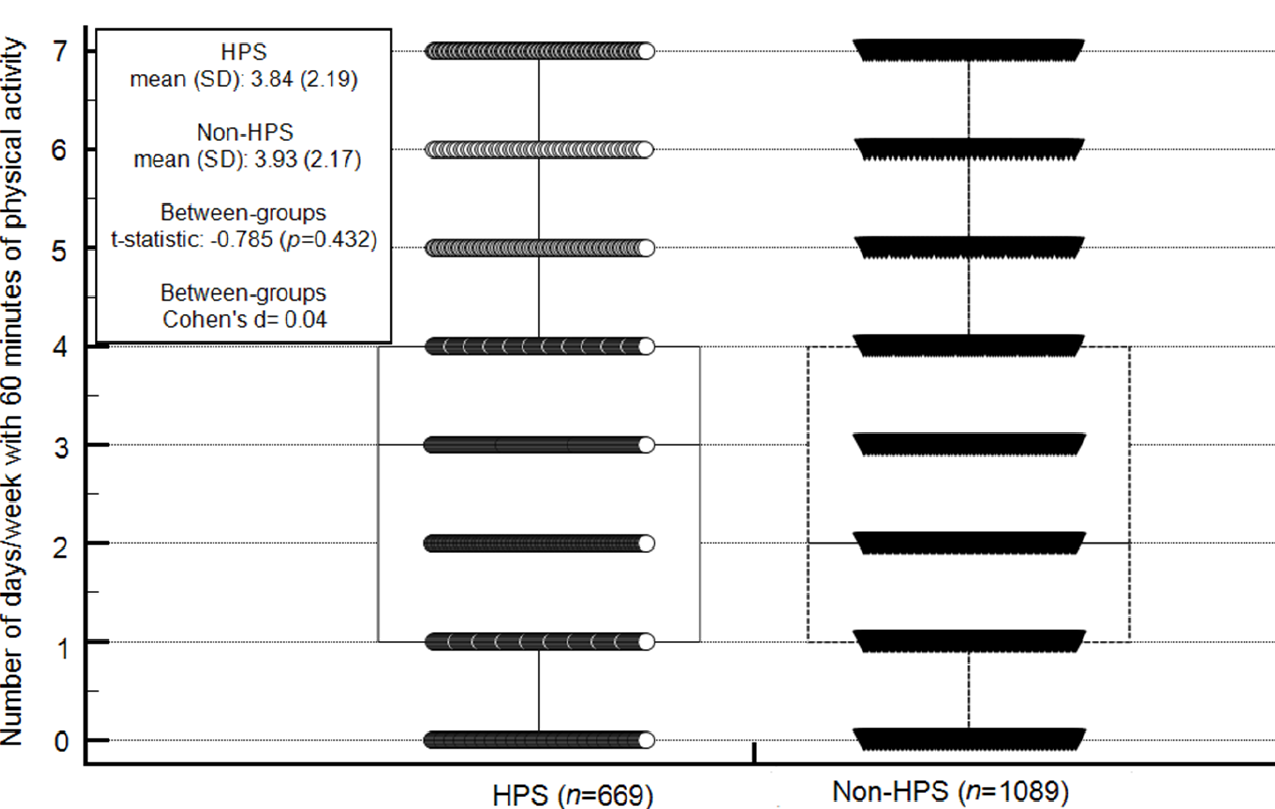
Figure 1. Between-group differences in number of days/week with 60 min of physical activity. Notes: HPS, health-promoting schools; Non-HPS, non-health-promoting schools; SD, standard deviation; in HPS and non-HPS, each circle or triangle, respectively, represents a child; The central box represents the lower to upper quartiles (25 to 75 percentile) of number of days/week in which children engaged in at least 60 min of physical activity; the vertical line extends from the minimum to maximum number of days/week with 60 min pf physical activity; The horizontal lines within the box represent the median number of days/week with 60 min of physical activity (HPS, 3 days/week, non-HPS, 2 days/week); no outside values were detected (an outside value was defined as a value that was smaller than the lower quartile minus 1.5 times the interquartile range, or larger than the upper quartile plus 1.5 times the interquartile range); the middle line represents the median.